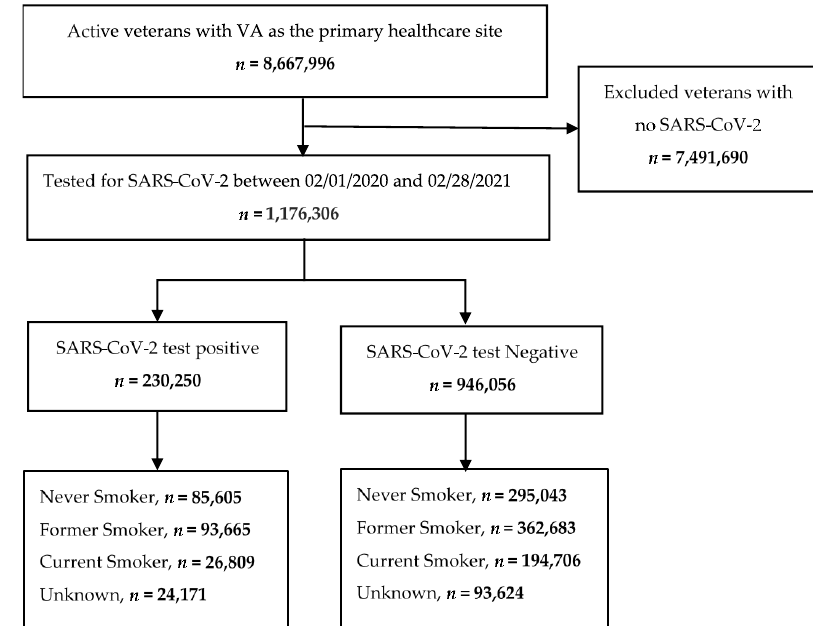
Figure 1. Strobe